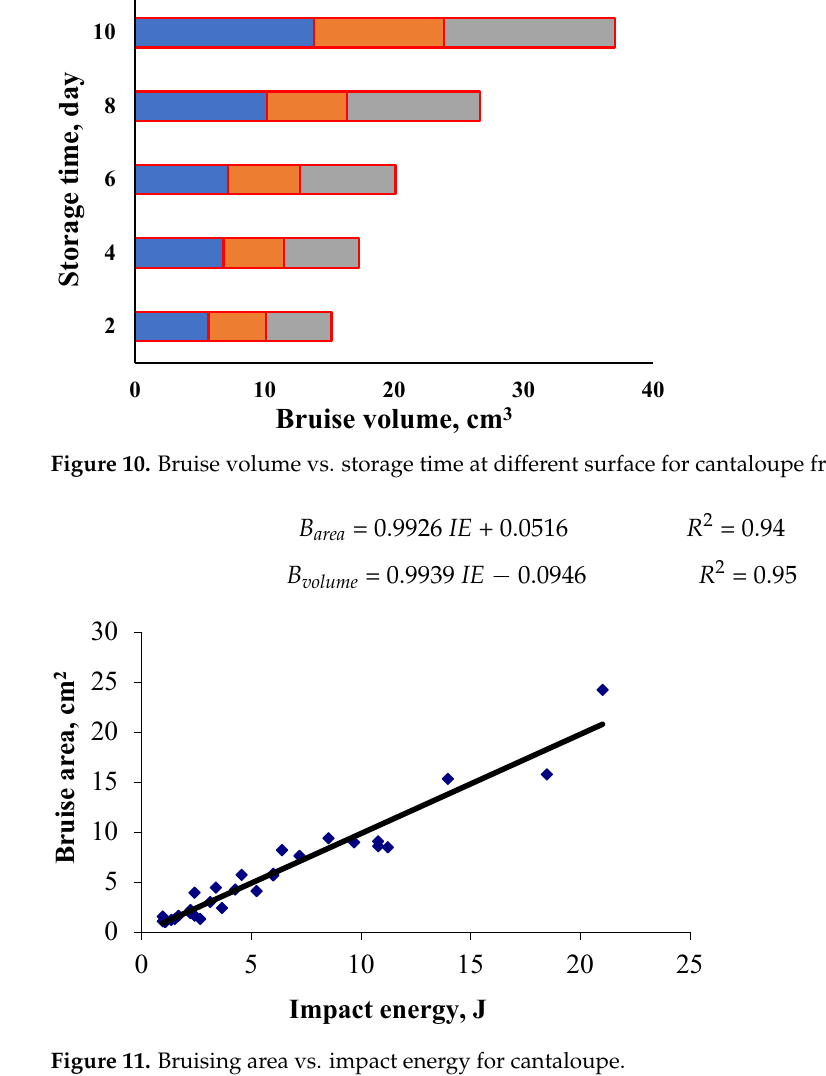
Figure 11. Bruising area vs. impact energy for cantaloupe.